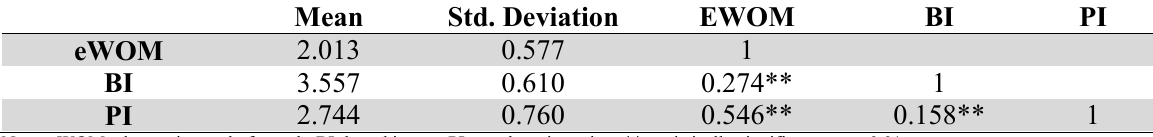
Results of the structural model for the correlations between eWOM, BI and PI Mean Std. Deviation EWOM BI PI